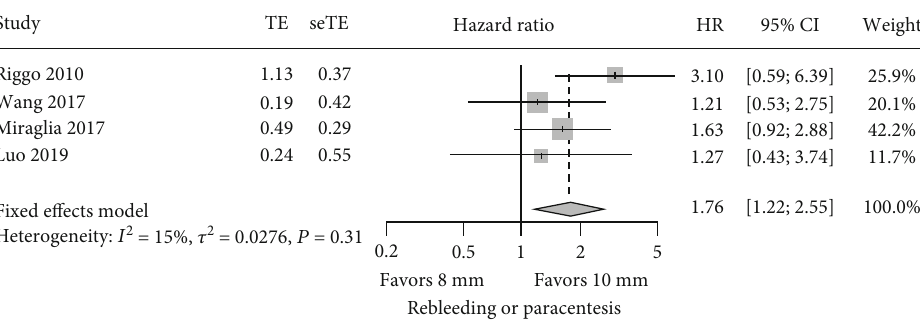
Figure 3: Meta-analysis of HR of rebleeding or paracentesis: 8mm vs. 10 mm stent TIPS.